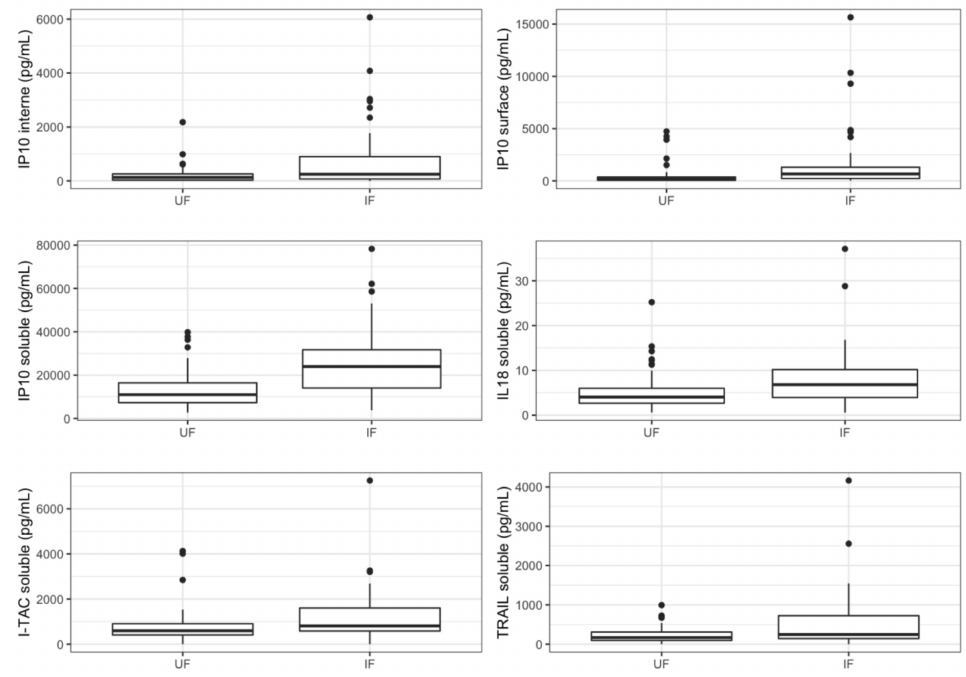
Figure 1. Concentrations of relevant cytokines according to fetal infection. Boxplots represent variations in cytokines’ concentrations (median). UF: uninfected fetuses, IF: infected